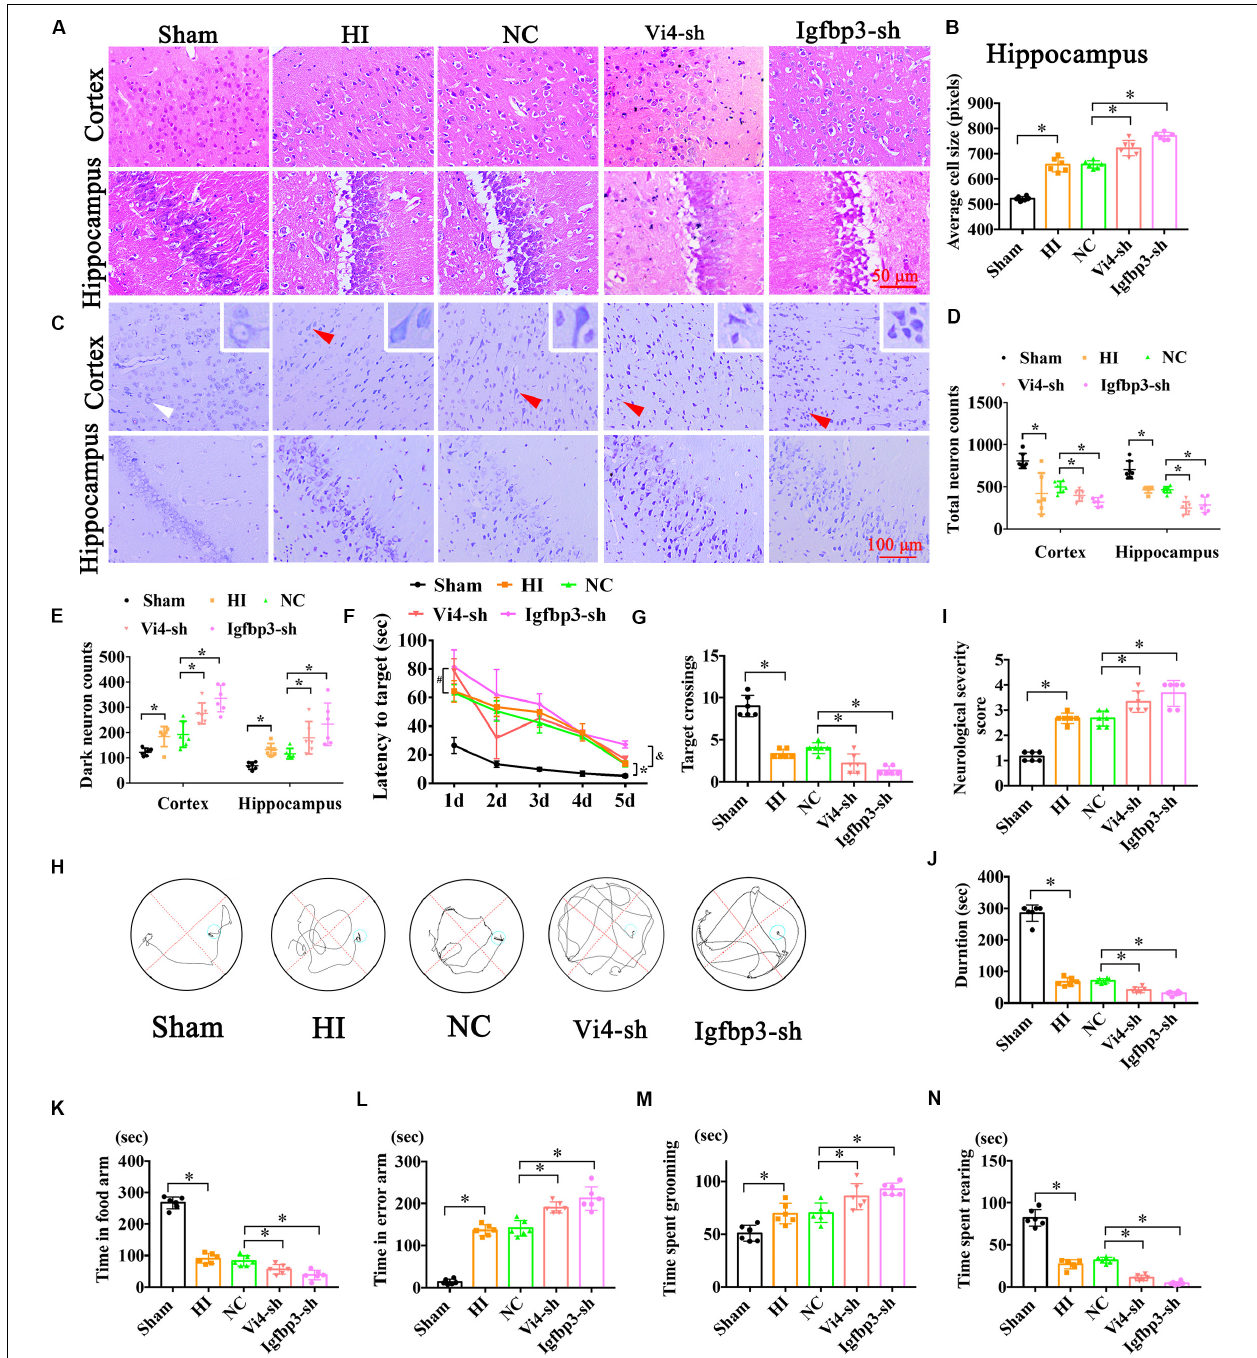
FIGURE 7 | The neurobehavioral tests of rats after intraventricular injection of Vi4-sh and Igfbp3-sh in vivo . (A,B) HE staining and the cell size analysis of cortex and hippocampus, respectively, in the rats of Sham, HI, NC, Vi4-sh and Igfbp3-sh. Scale bar = 50 µ m, n = 6/group. (C) Nissl staining in cortex and hippocampus among sham, HI, NC, Vi4-sh and Igfbp3-sh groups. The white arrow represents surviving neurons. The red arrow represents dark neurons. Scale bar = 100 µ m. (D,E) Quantitative histogram for total neuron and dark neuron in these groups, n = 6/group. (F) The latency to target during 5 days training among the sham, HI, NC, Vi4-sh and Igfbp3-sh groups after HI in MWM test. * P < 0.05: HI vs. Sham. # P < 0.05: Vi4-sh vs. NC. & P < 0.05: Igfbp3-sh vs. NC, n = 6/group. (G) Target crossings in MWM test after HI, respectively, n = 6/group. (H) The walking path of the platform in probe trial of Morris Water Maze test at day 5 after HI. (I) NSS score among the sham, HI, NC, Vi4-sh and Igfbp3-sh groups post HI, n = 6/group. (J) The duration of rats on rotary bar in the rotarod test after HI, n = 6/group. (K,L) The time arms of food and error arms in the sham, HI, NC, Vi4-sh and Igfbp3-sh groups after HI in the Y-maze test, n = 6/group. (M,N) The time spent grooming and rearing in the open field experiment after HI, n = 6/group. All data were presented as mean ± SD, ∗ P < 0.05.